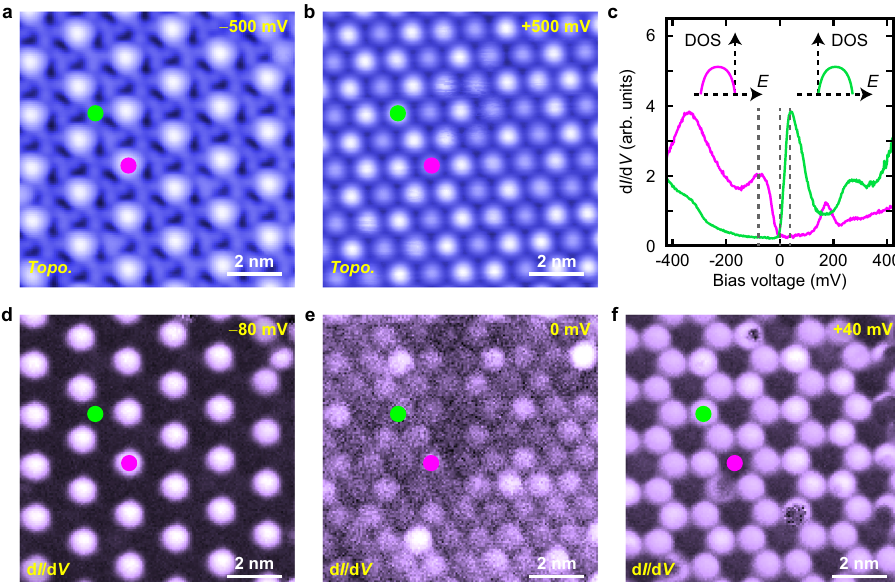
ffiffiffi p ffiffiffi p Fig. 5 Electronic states in the 3 × 3 superstructure. a Constant-current STM topography taken on the Type-II 1 T -TaS 2 surface with negative bias voltage ( V s = − 500mV, I = 20 pA). b Constant-current STM topography taken with positive bias voltage on the same region as a ( V s = + 500 mV, I = 20 pA). c d I /d V spectra taken on the purple and green dots shown in a , b . The insets show the energy positions of the narrow electronic band on the purple and green dots shown in a , b . d – f d I /d V maps taken on the same region as shown in a , b with − 80mV ( d ), 0mV ( e ) and + 40mV ( f ) bias voltages, respectively. The data shown in this fi gure are taken at T = 4.3K. Source data are provided as a Source Data fi